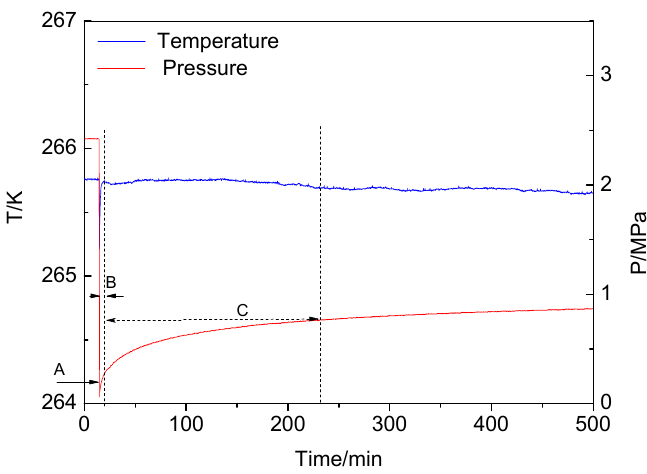
Figure 9. Decomposition from low pre-decomposition pressure.